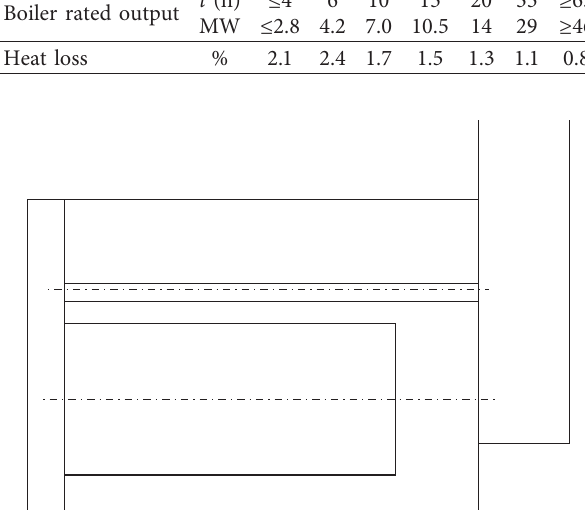
Figure 1: Schematic diagram of the central flame-return structure of a horizontal hot water machine.